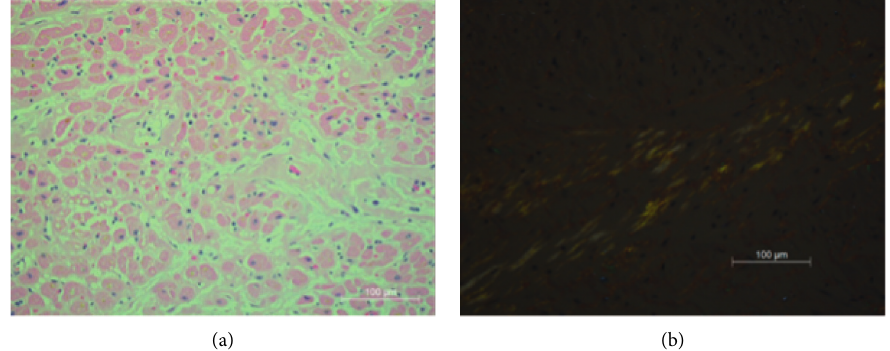
Figure 5: (a) Infiltrative amyloid deposits noted among the myocytes on hematoxylin and eosin stain. (b) Congo red stain with apple-green birefringence within the right and left ventricle